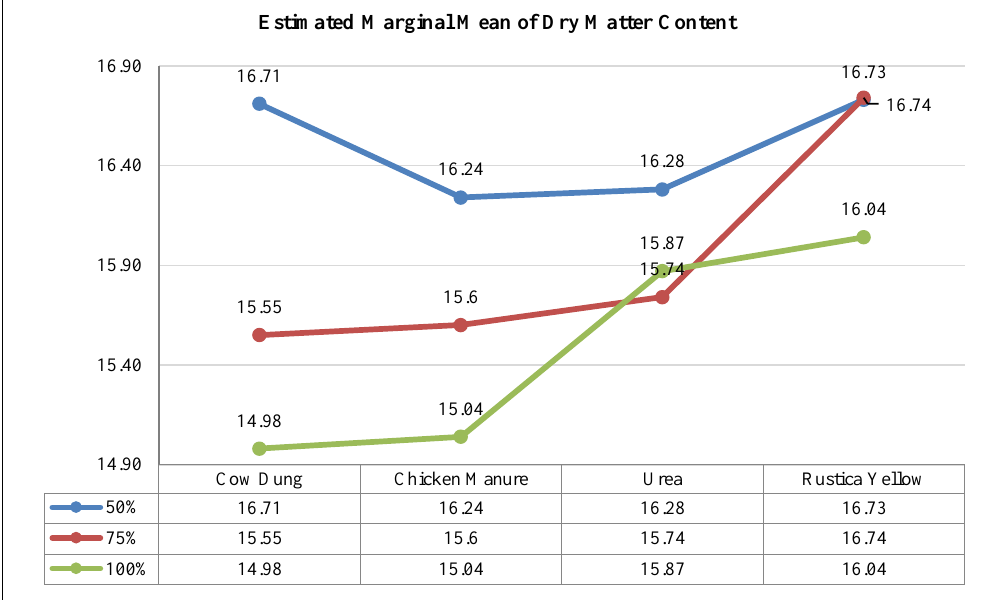
Figure 7. Nitrogen Sources Effects and Levels on Dry Matter